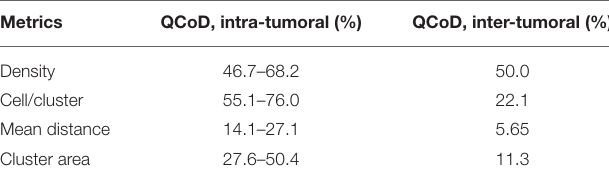
TABLE 1 | Intra- and inter-tumoral QCoD for spatial statistics.